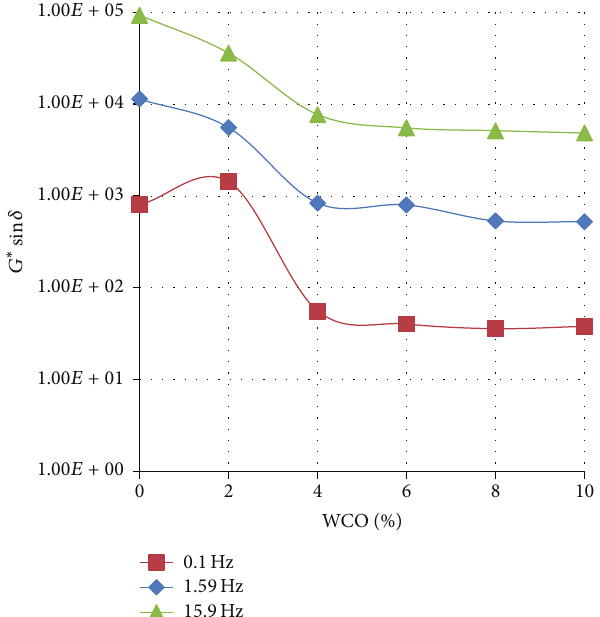
Figure 5: The variation of the rutting resistance parameter ( 𝐺 ∗ / sin 𝛿 ) with increasing concentration of WCO in TPB at various oscillating frequencies at 60 ∘